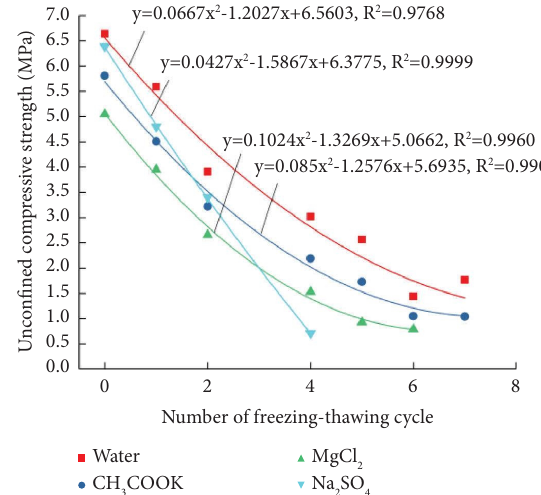
Figure 12: Relationship between unconfned compressive strength and number of freezing-thawing cycles of the cemented soil without fbers.